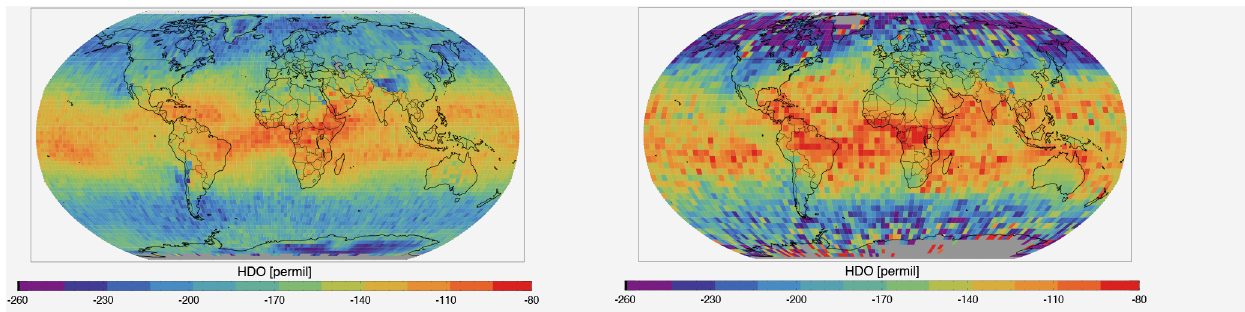
Figure 3. Water vapor isotopic composition ( δ D) measured from TES (version 5, year 2006, weighted averaged from 900 to 425hPa, left panel) and SCIAMACHY (average over 2003 to 2005, total column, right panel) satellites. Red colors indicate an enrichment in heavy isotopes and blue and purple colors indicate a depletion in heavy